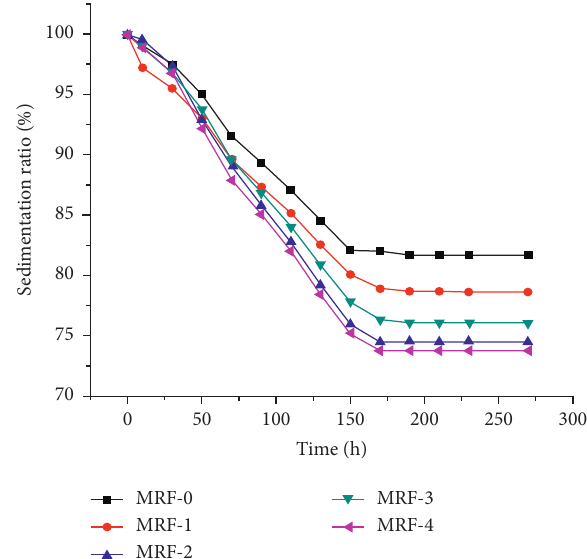
Figure 10: Sedimentation ratio of MRF before and after experiments.